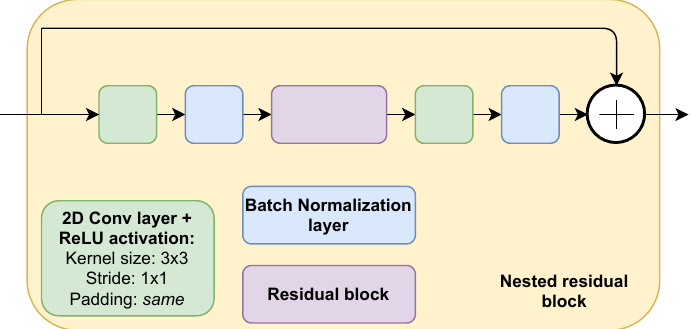
Figure 9. In-detail structure of the nested residual blocks in the model by Choi et al.